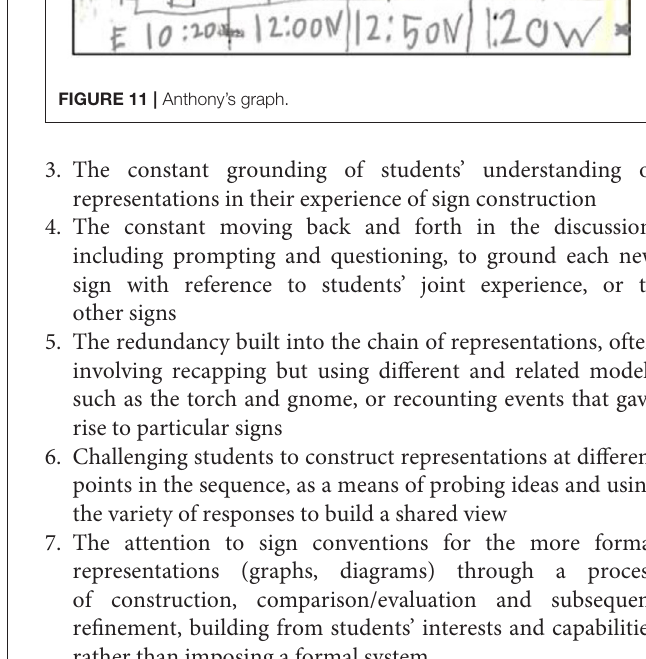
FIGURE 10 | (A) “As the sun started to track to the west the … shadow got longer again.” (B) “Because, as the sun gets lower in the sky to make our shadow get long again.”